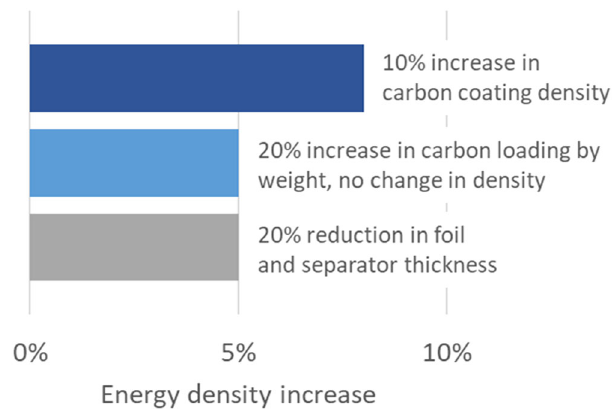
Fig. 3 Examples of possible energy density increase strategies for industrial supercapacitors. The data are calculated separately (i.e., the cumulative effect is not considered), taking into account inactive materials and manufacturing processes changes. The calculations are carried out using an industrial cylindrical wound core cell model developed by Skeleton Technologies GmbH. The model speci fi cations are property of Skeleton Technologies GmbH and not publicly available.